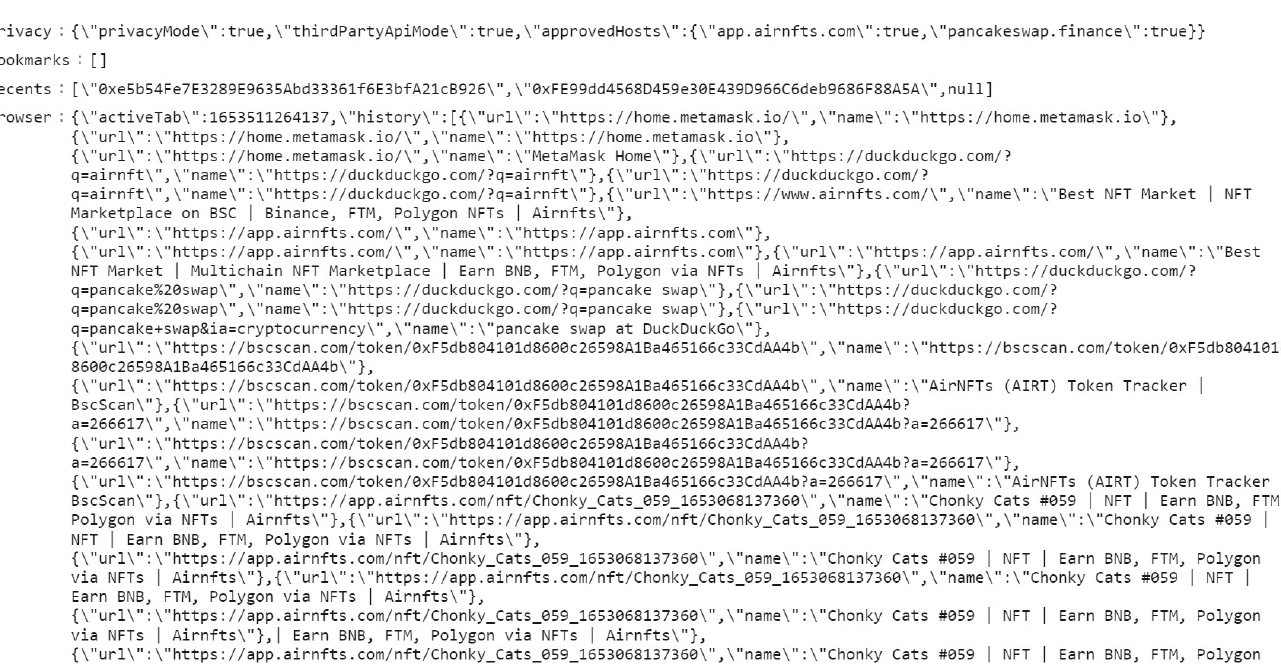
Figure 26. Privacy settings, resents, and browser activity objects within the persist-root